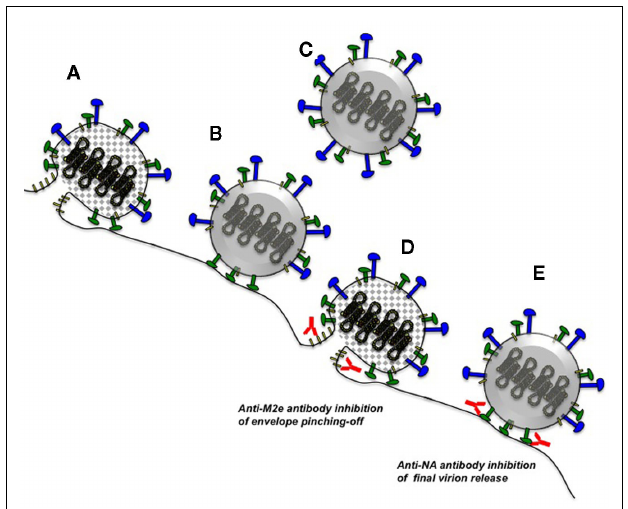
FIGURE 3 | Influenza virus release and possible mechanisms for antibodies against NA and M2e. Infected host cells package eight ribonucleoprotein genome segments into viral buds formed by M1 capsid monomers ( gray diamonds ) and host plasma membrane containing HA, NA, and M2 (A) . M2 catalyzes membrane fusion to pinch-off newly budded virions, which initially remain tethered to sialic acid on the host-cell surface (B) . NA enzymatic activity cleaves the interactions of tethered HA (not depicted) and NA with sialic acid, effectively releasing the new virions (C) . Antibodies against M2e may interfere with the pinching-off stage of viral budding (D) , whereas antibodies against NA may prevent final release of the virion (E) . See Figure 2 for symbol legend. Not drawn to